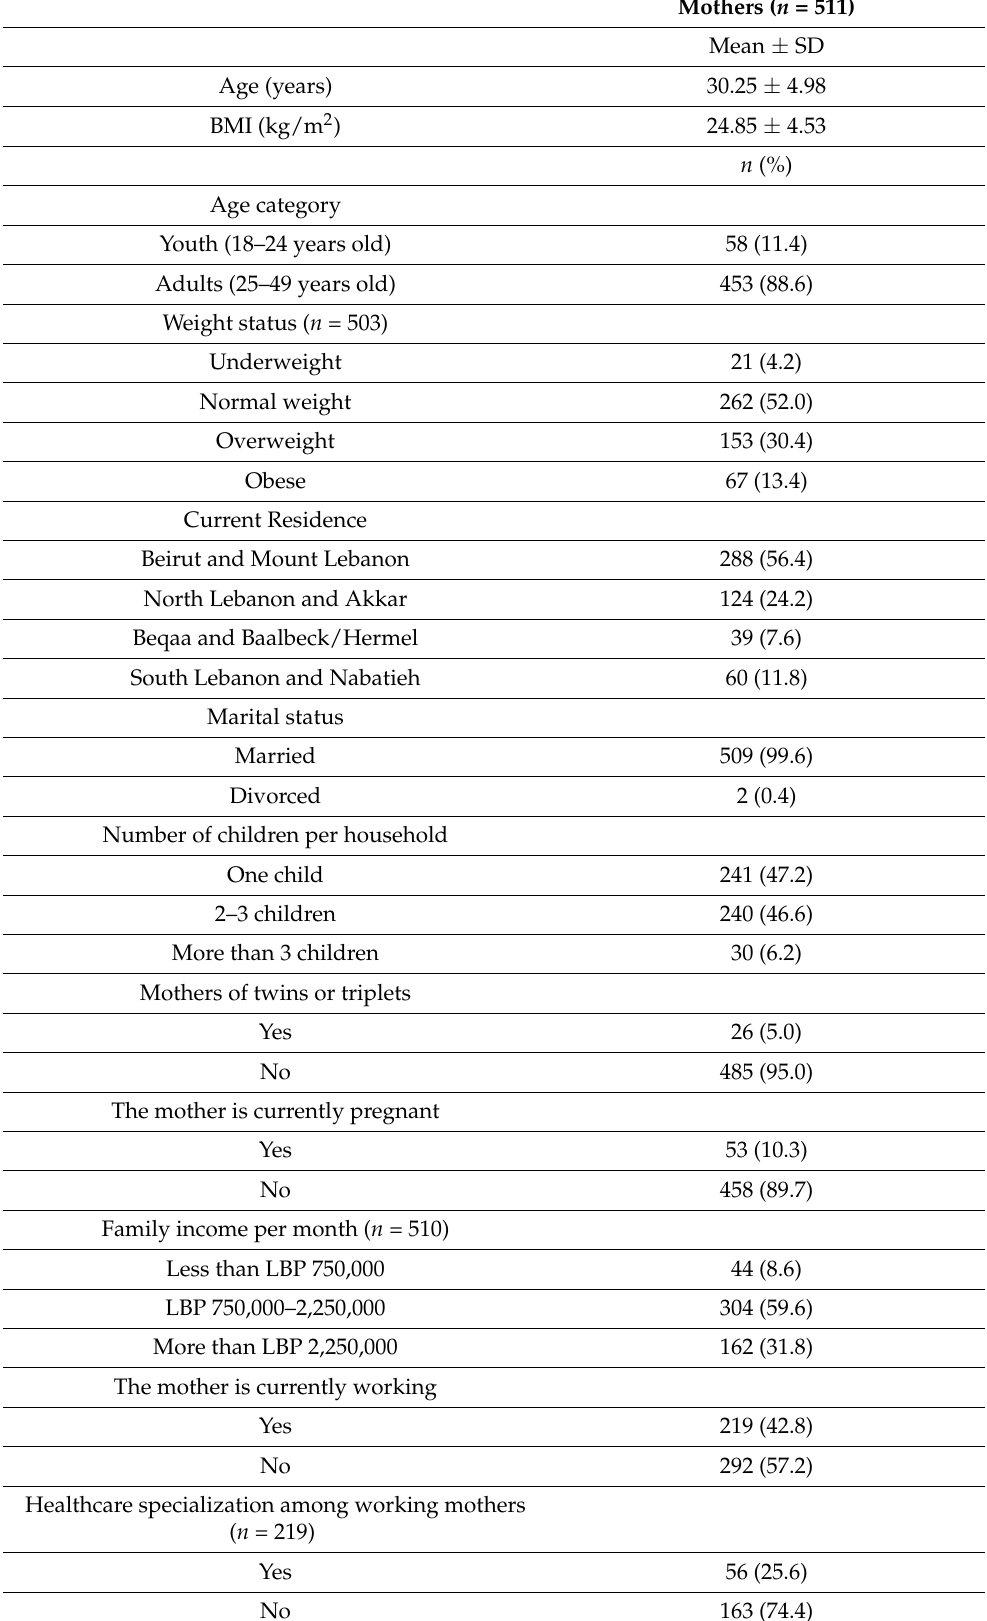
Table 1. General characteristics of the mothers in this